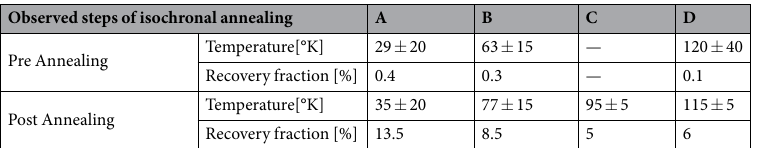
Table 2. Isochronal recovery steps temperature and recovery